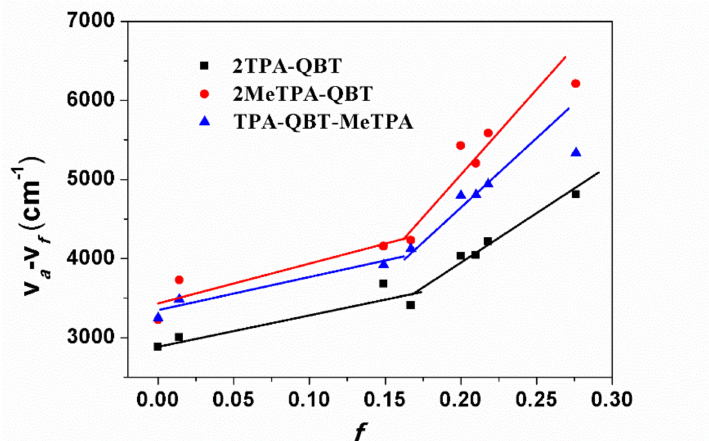
Figure 5. Linear correlation of orientation polarity f of solvent media with the Stokes shift (v a -v f ) for all